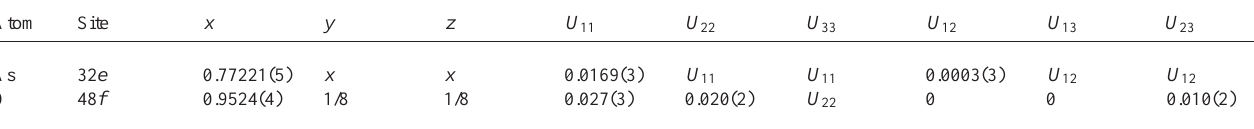
Table 2. Atomic coordinates and displacement parameters (in Å 2 ) . Atom